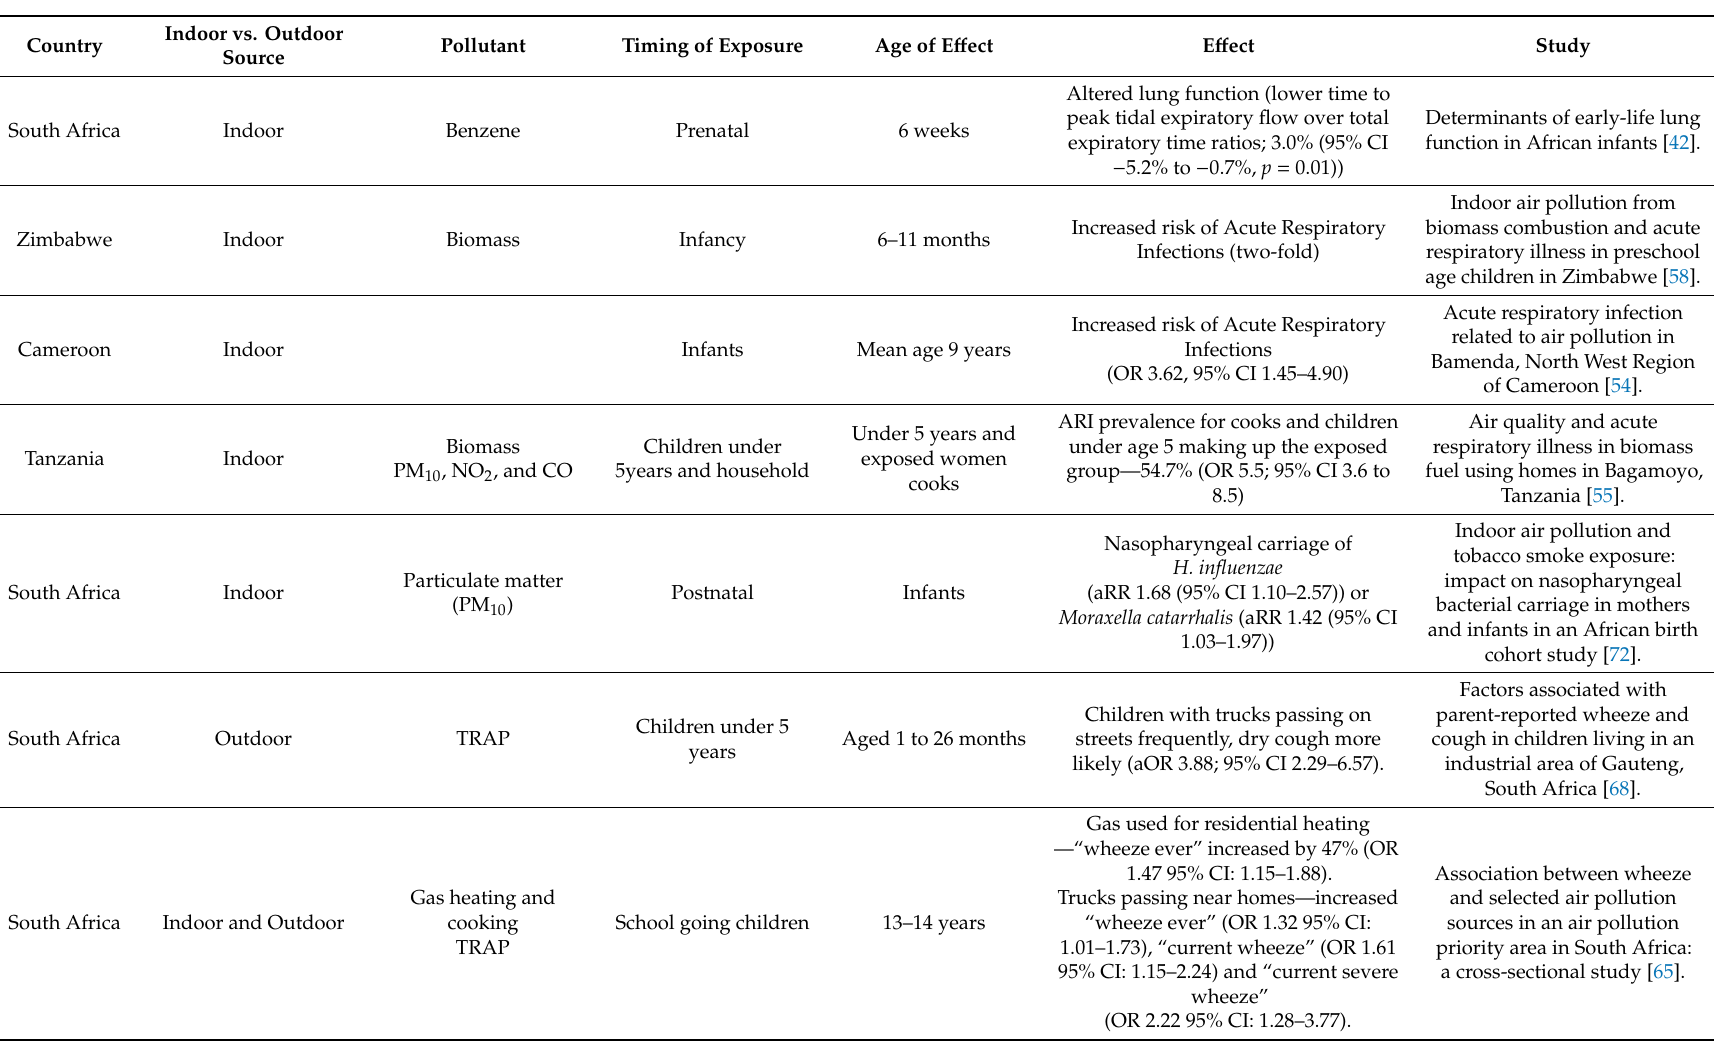
Table 2. Impact of air pollution on lung